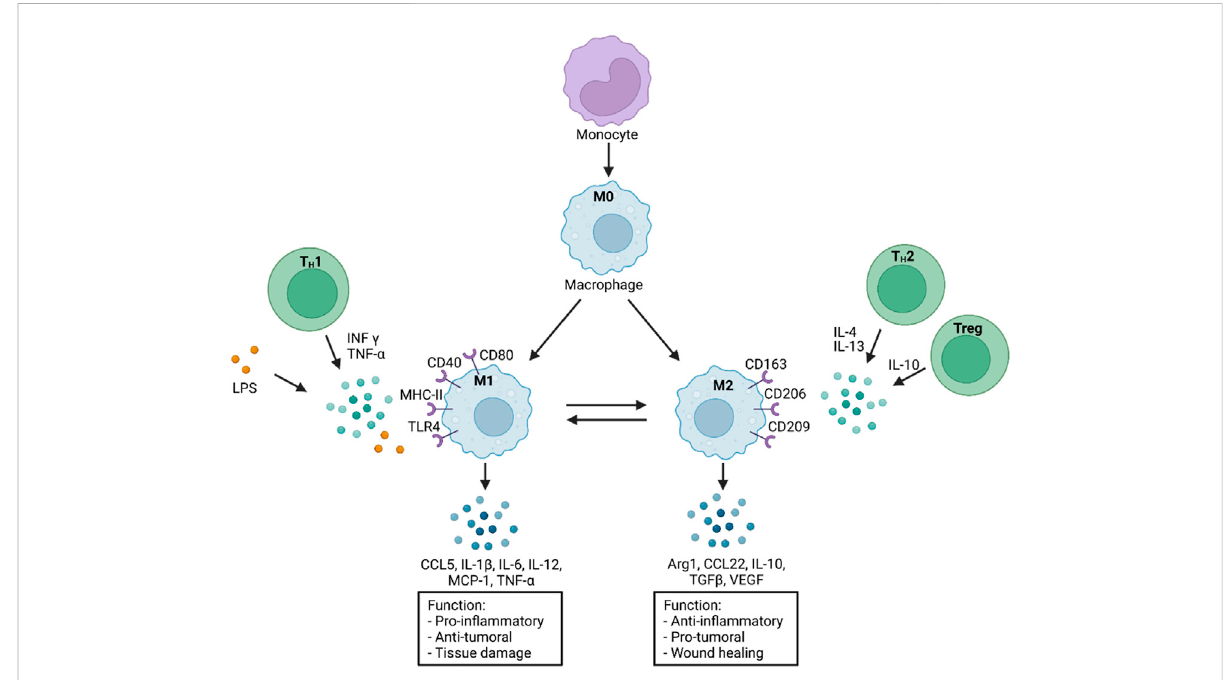
FIGURE 2 Monocyte differentiation and macrophage polarization in response to various stimuli. A selection of distinct functions is presented on the bottom. M0: macrophages without polarization; INF- γ : Interferon gamma; TNF- α : Tumor necrosis factor alpha; LPS: Lipopolysaccharide; CD: Clusterofdifferentiation;MHC-II:Majorhistocompatibilitycomplex-II;TLR4:Tolllikereceptor4;CCL5:CC-Chemokineligand5;MCP-1:Monocyte chemoattractant protein-1 (CCL2); IL: Interleukin; TGF β : Transforming growth factor β ; Arg1: Arginase 1; VEGF: Vascular endothelial growth factor; Treg: Regulatory T cells; T H 1/2: T Helper cells 1/2. Scheme was summarized from data in (Yao et al., 2019; Daiber et al., 2021). Created with